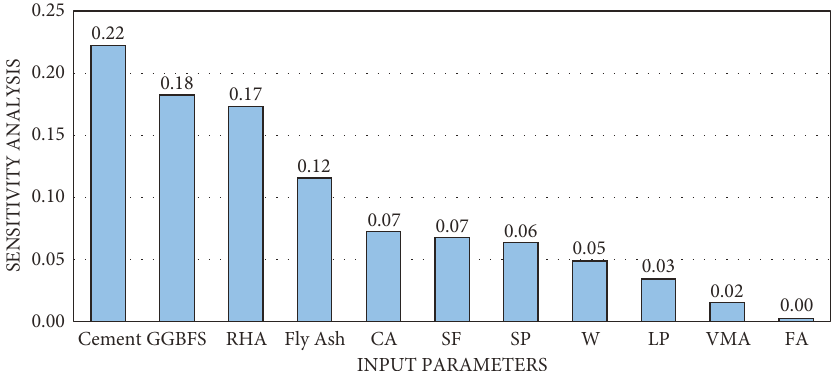
Figure 12: Relative impact of factors on the compressive strength of self-compacting